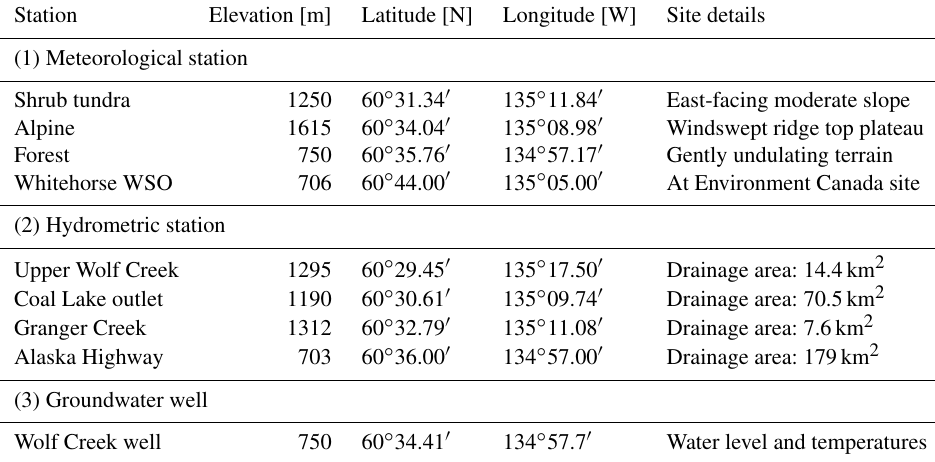
Table 1. Description of the main meteorological and hydrometric stations within Wolf Creek Research Basin.